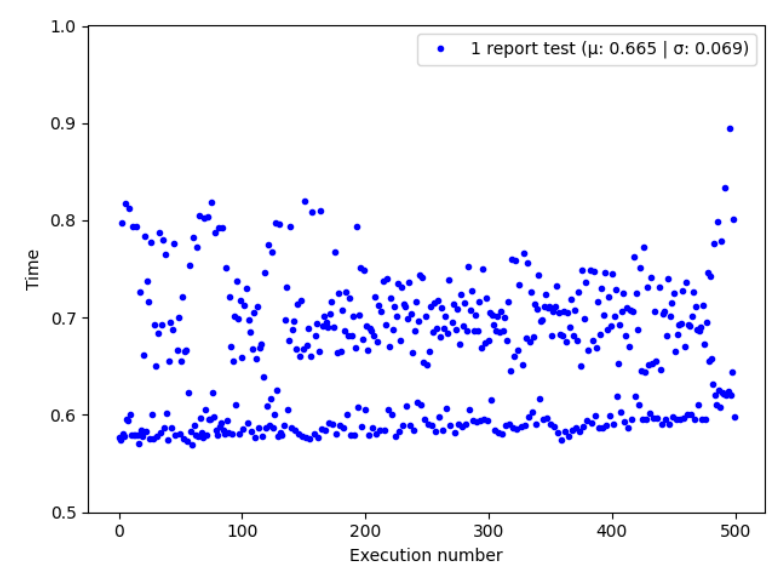
Figure 4. Time required to query a single report.